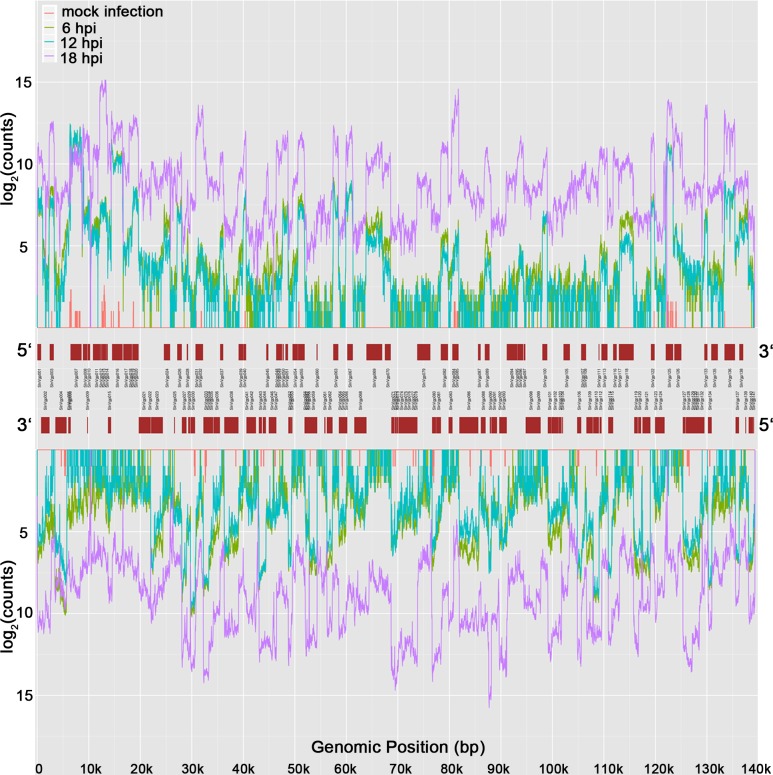
Unique ORF reads mapped to sense strand and anti-sense strand at 6, 12 and 18 hpi.6 hpi: green line; 12 hpi: blue line; 18 hpi: purple line.